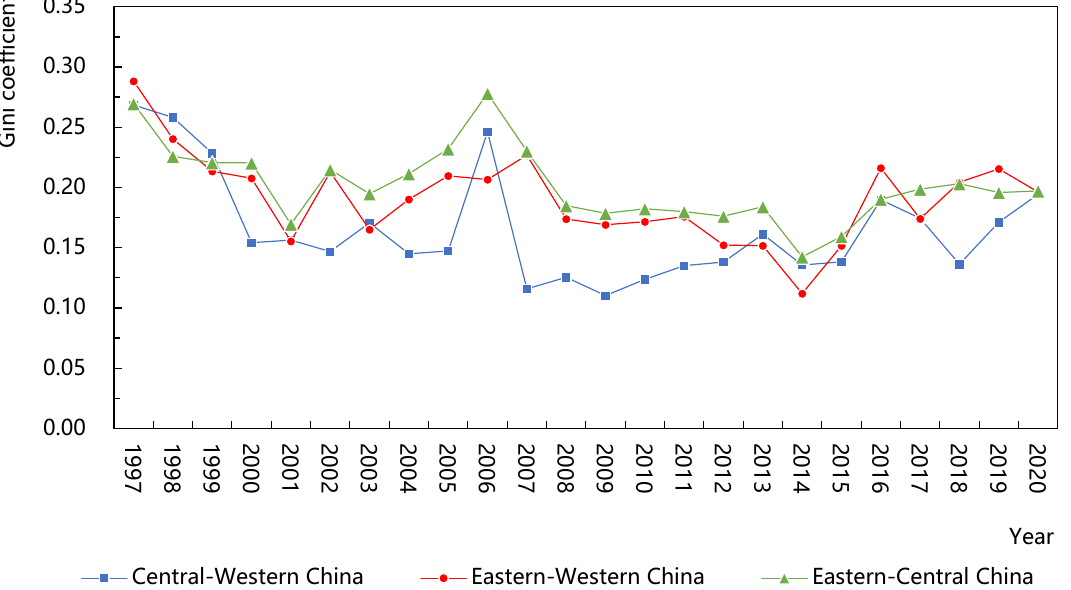
Figure 4. Variation in Dagum Gini coefficient between regions.